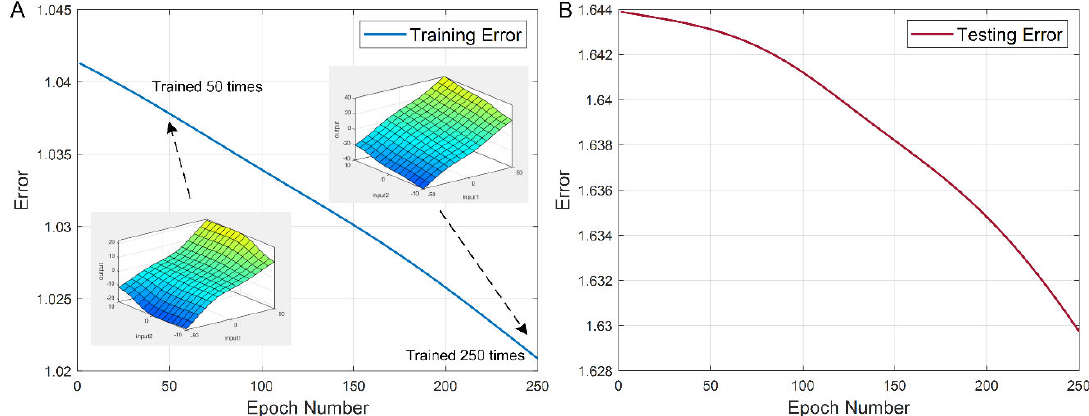
Figure 6. The error of training. ( A ) The curve of training error. ( B ) The curve of testing error.